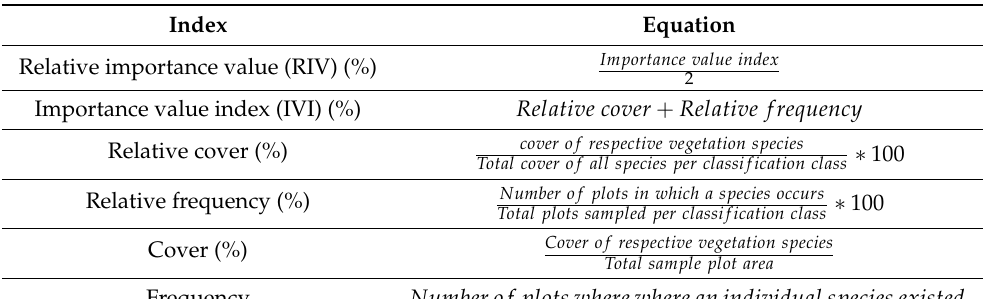
Table 3. Description for determining the Importance value index for each vegetation species identified and documented.